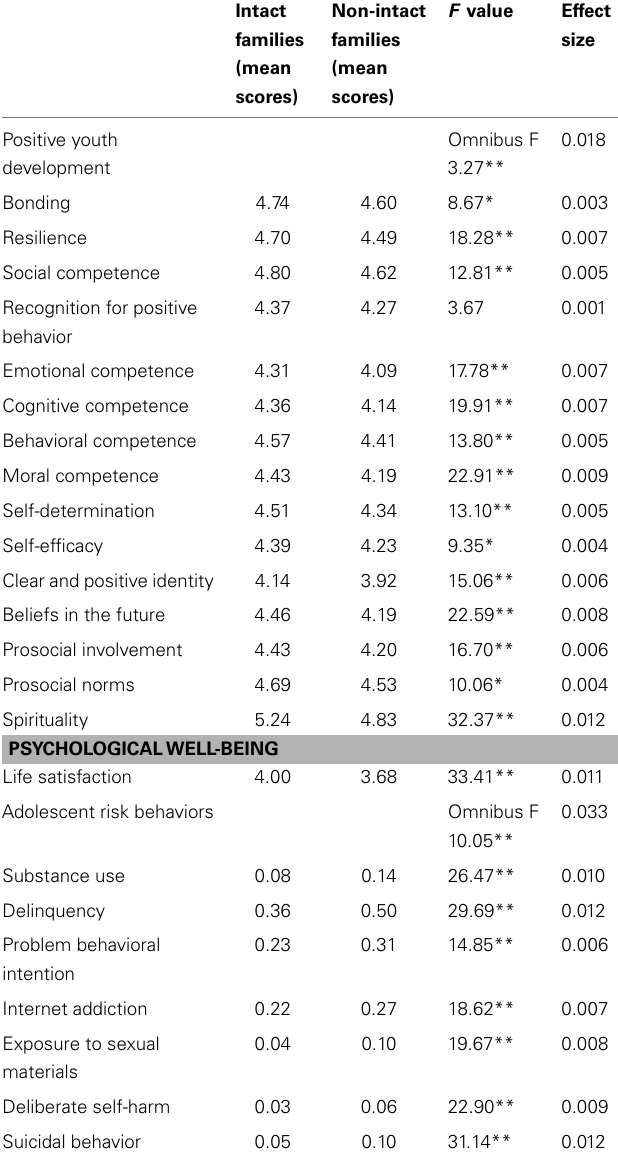
Table 2 | Effect of family types (intact vs. non-intact) on positive youth development, psychological well-being, and adolescent